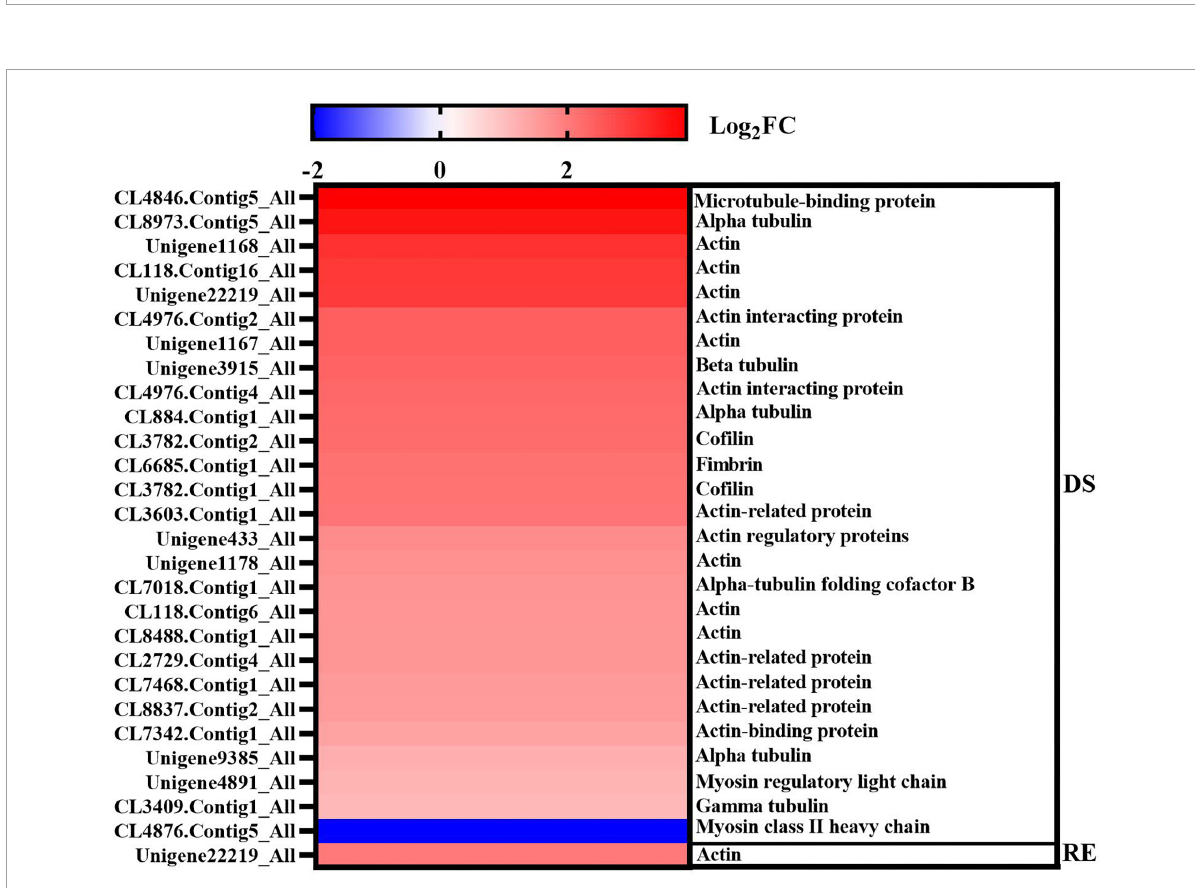
FIGURE7 Differentially abundant proteins related to the cytoskeleton under dessication and rehydration. The left and right Y axes represent the protein ID and functional annotation, and DS and RE represent dessication-stress and rehydration, respectively.